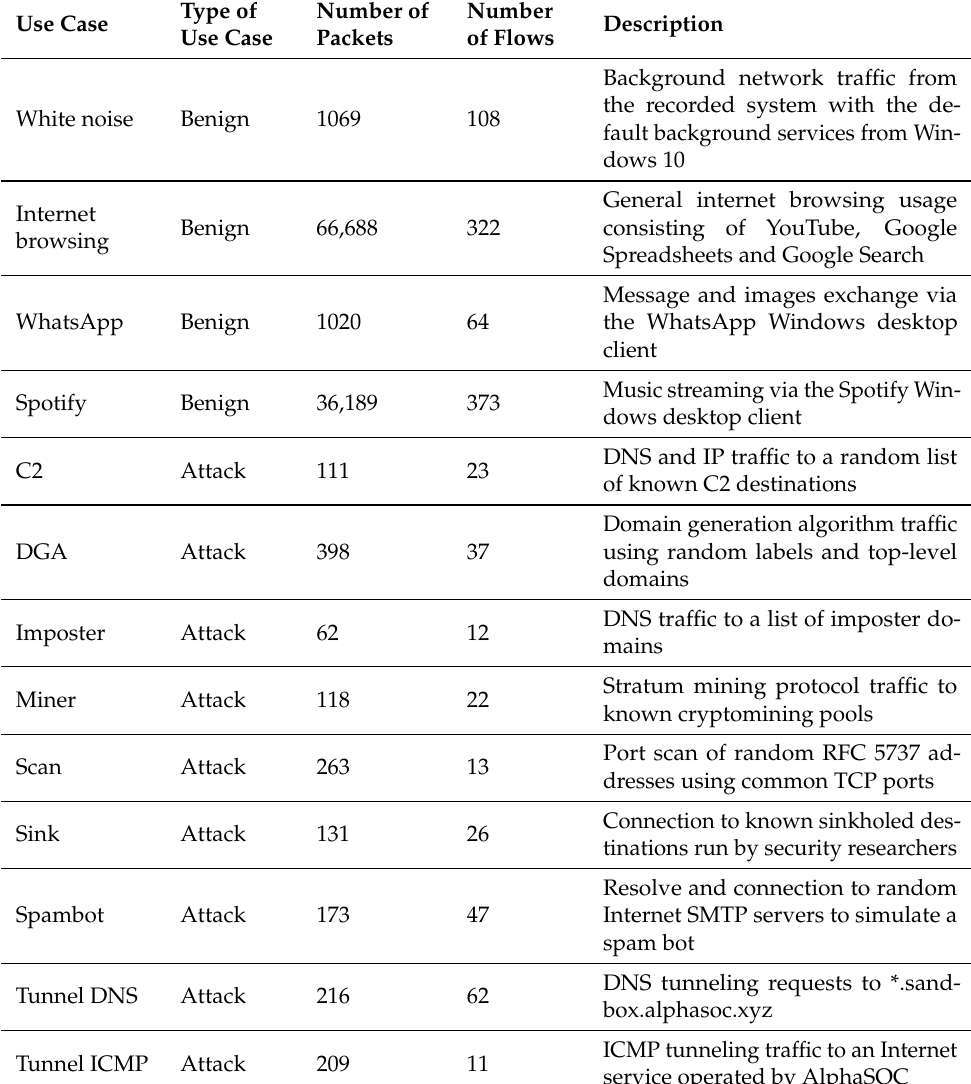
Table 3. Recorded network use